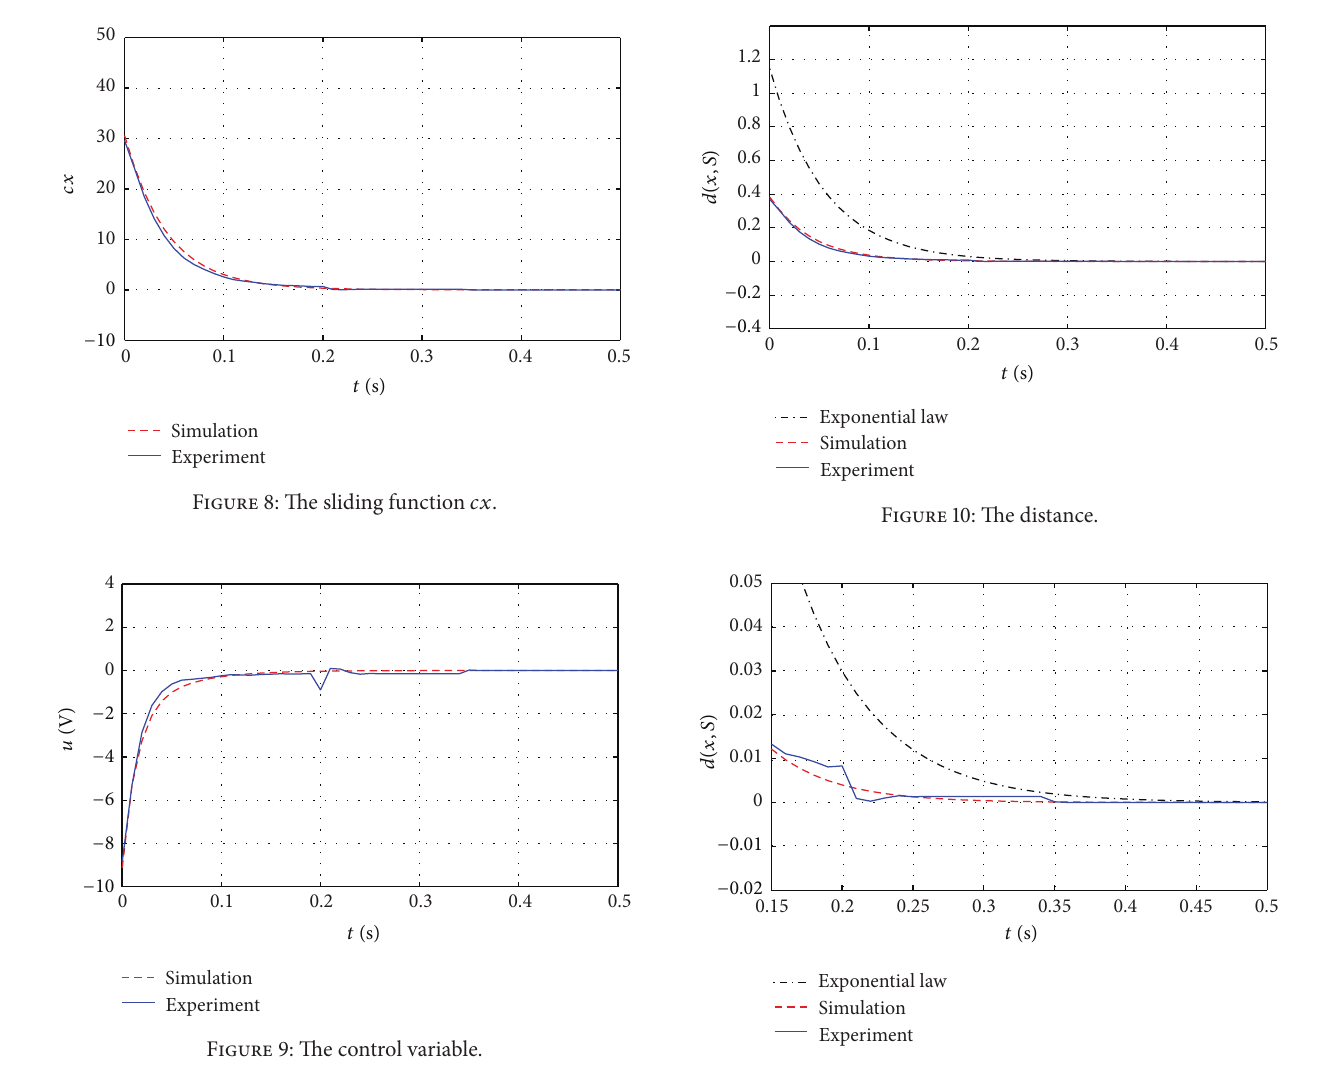
Figure 11: Augmented part of Figure